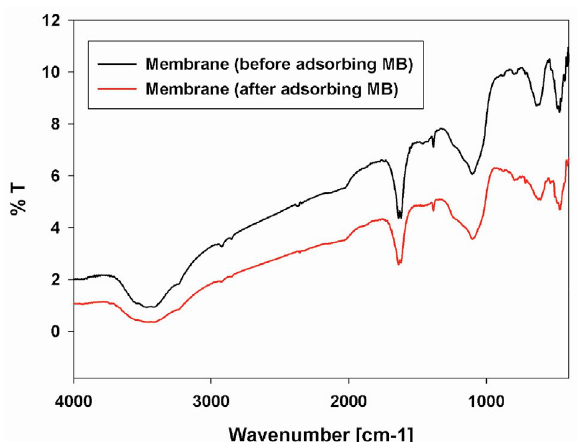
Figure 6. FTIR of a) fired kaolin at 1000 °C before adsorption and b) covered with methylene blue after